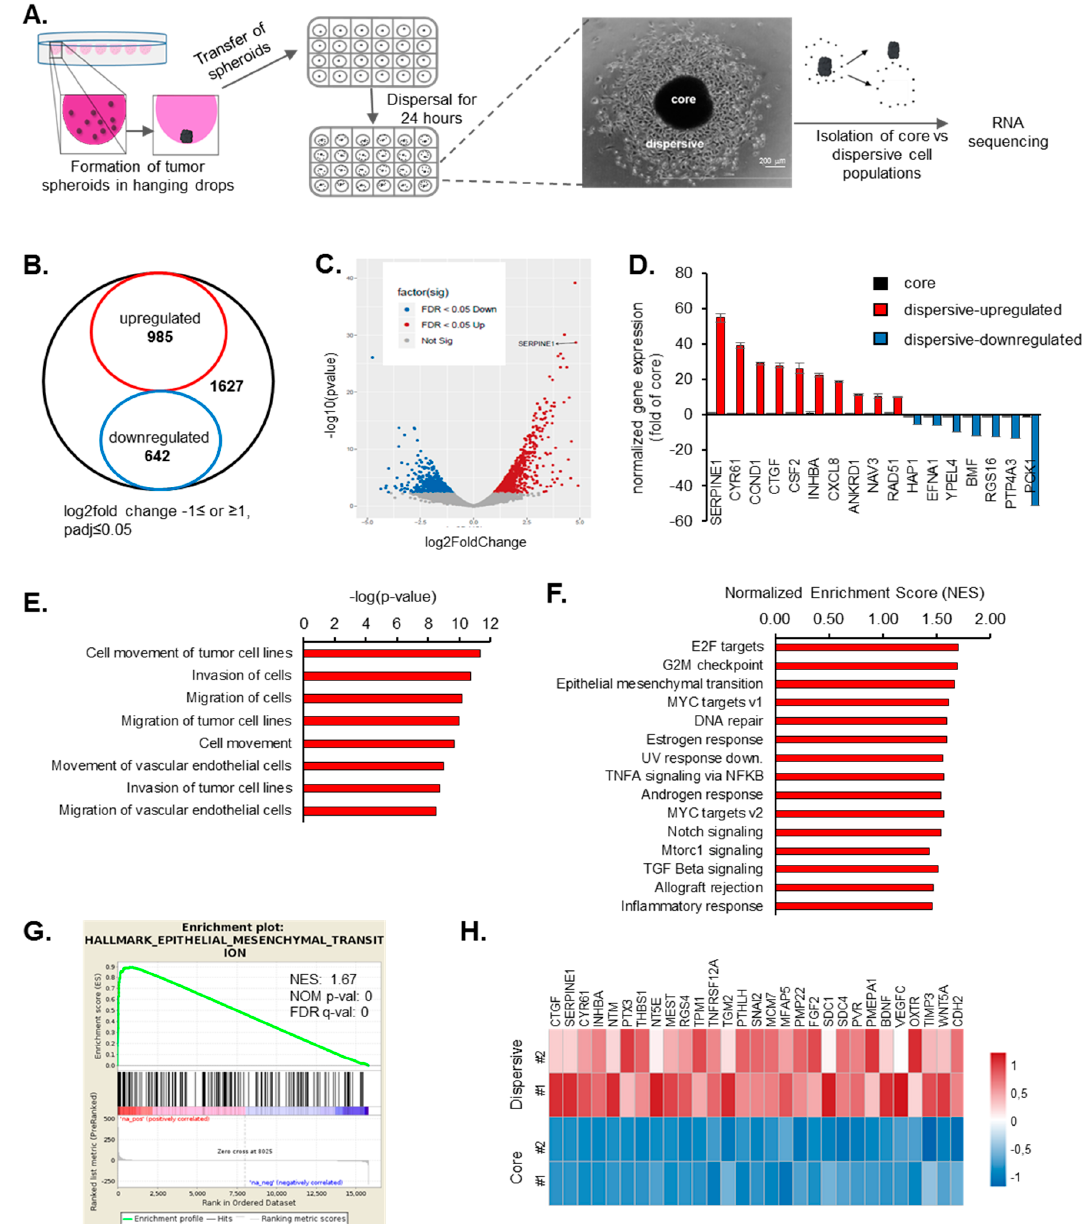
Figure 1. Transcriptome of motile and non-motile cells have major differences and SERPINE1 is the top upregulated gene in dispersive cells. ( A ) hanging drops method was used to generate tumor-mimicking spheroids. After formation of tumor spheroids in hanging drops, spheres were transferred to 24-well plates and allowed to disperse for 24 hours. Core and dispersive cells were collected separately for RNA sequencing. ( B ) total 1627 genes were differentially expressed between motile and non-motile cells (log2 fold change -1 ≤ or ≥ 1, padj ≤ 0.05); ( C ) volcano plot showing the upregulated (red) and downregulated (blue) genes in dispersive cells; ( D ) qRT-PCR validation of top differentially expressed genes in core and dispersive cells; ( E ) “Diseases and bio functions” from IPA core functional analysis of the differentially expressed genes related to “cell movement” in the dispersive